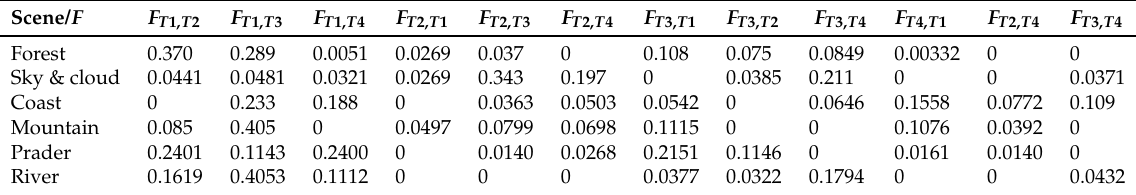
Table 3. The τ matrix resulting from the manual selection of the highest significant causal relationships. Scene/